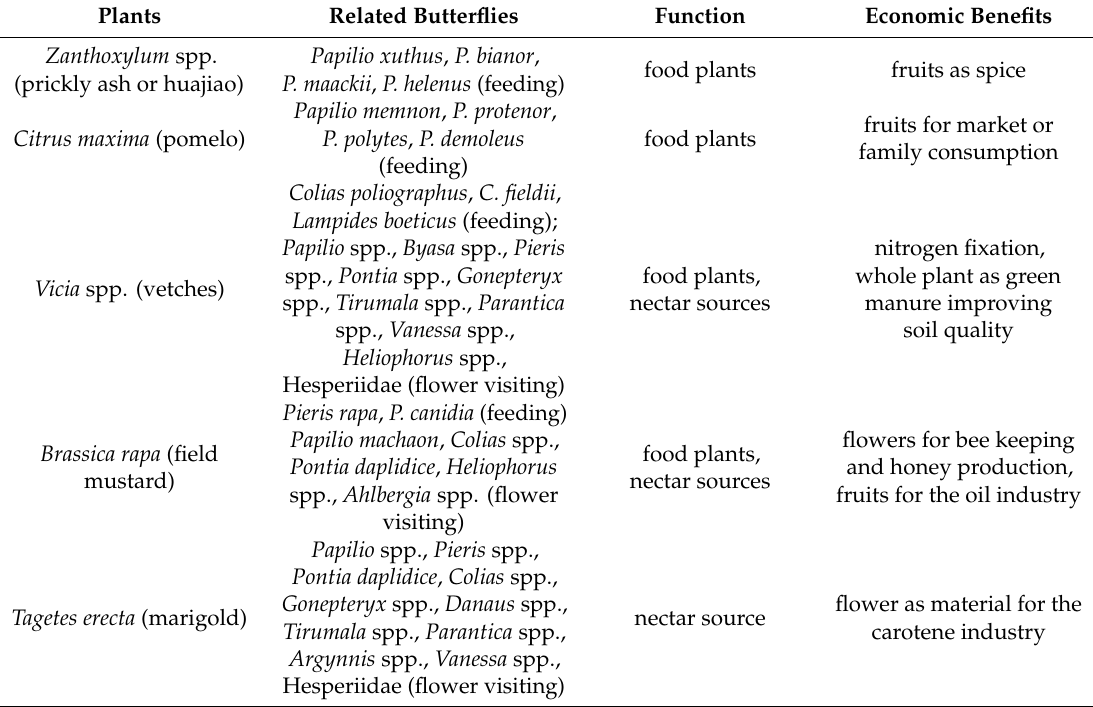
Table 2. Examples of butterfly attracting plants and their known economic benefits. Plants Related Butterflies Function Economic Benefits Zanthoxylum